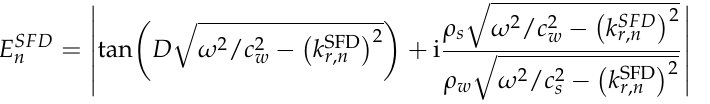
Figure 7. The TL contour in the Pekeris waveguide case using the NFD with PPW = 6 (the black dotted line shows the seabed). Figure 8. The TL contour in the Pekeris waveguide case using the SFD with PPW = 20 (the black dotted line shows the seabed).